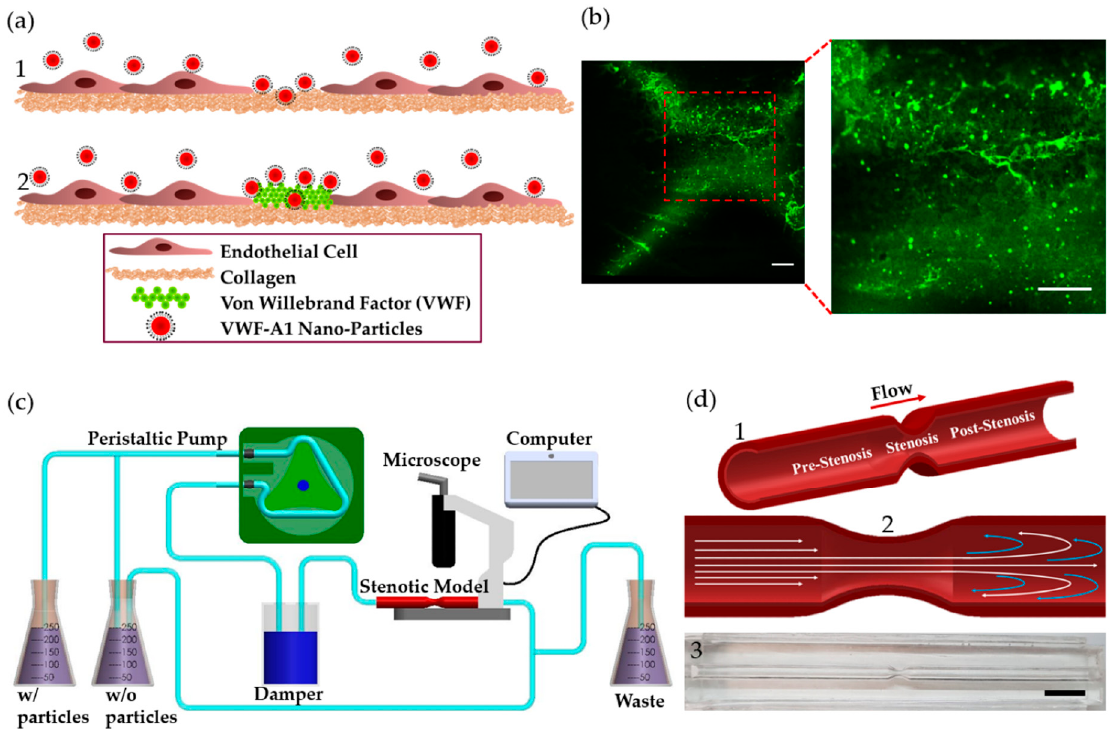
Figure 1. VWF-A1 nanoparticles interactions at injury site and stenotic models. ( a ) A1-functionalized nanoparticles interactions at injury site at different stages of arterial thrombosis: (1) Initially, collagen is exposed (2) Thenceforth, VWF adheres to the exposed collagen. ( b ) Fluorescent microscopy images showing labeled VWF immobilized inside the coronary stenotic model. Scale: 50 µ m ( c ) The experimental perfusion system comprising: A peristaltic pump, a damper, containers, and the stenosis models placed under a microscope. 5 µ g of A1-NPs were injected into 300 mL dextran solution, having a viscosity of 3.5 mPa · sec, which circulates through a stenosis model via a closed loop flow system. ( d ) The coronary stenosis model. (1) Schematic representation of a coronary stenosis model. (2) Schematic illustration of spatial flow patterns in the stenotic blood vessel. (3) A picture of the PDMS-based 75% stenotic model. Scale: 1cm.